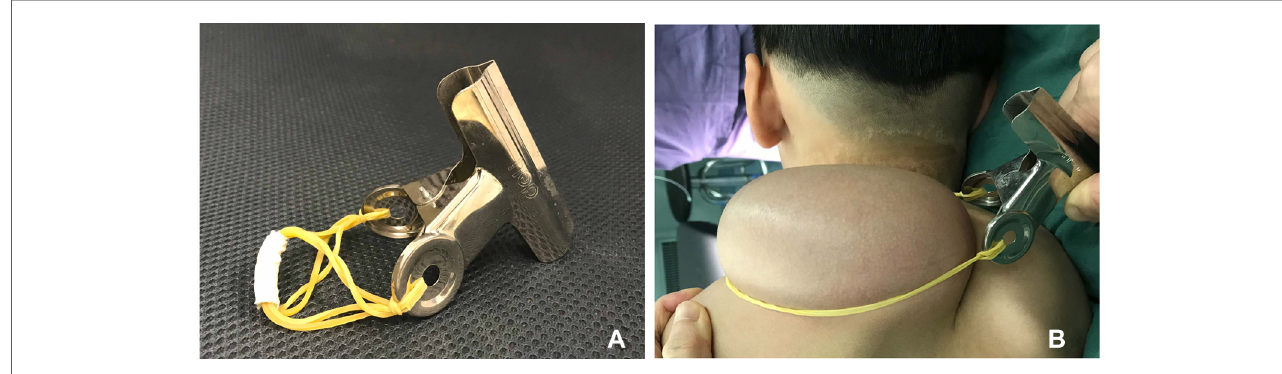
FIGURE 3 Testing the circulation of the expanded fl ap. ( A ) Device for testing the circulation. ( B ) Testing the circulation of the expanded fl ap.